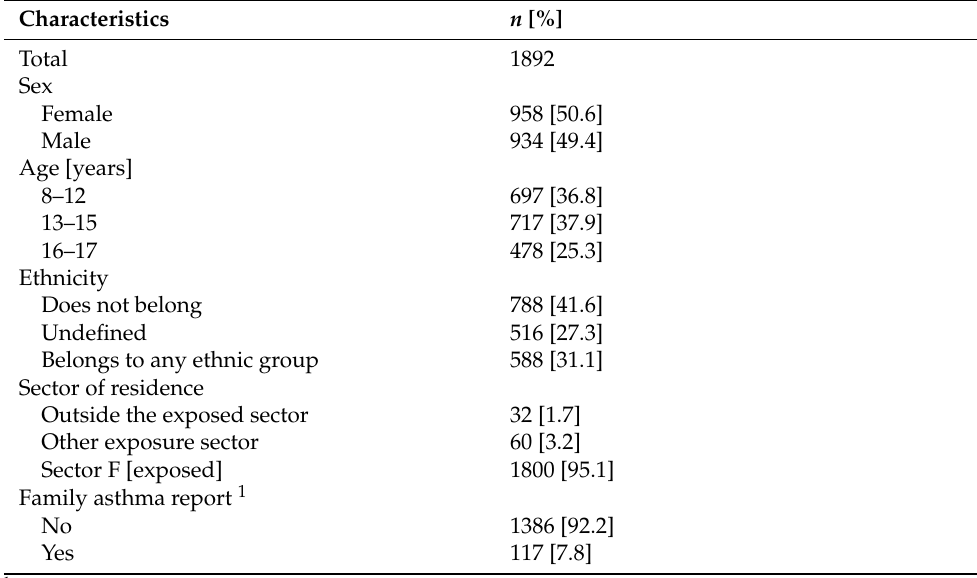
Table 1. Sociodemographic characteristics of the sample from Arica (2009–2021).